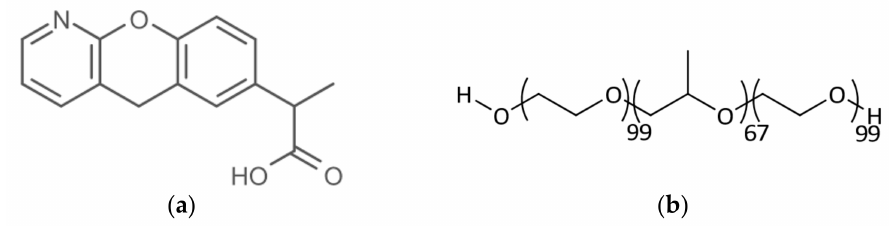
Figure 1. ( a ) Pranoprofen chemical structure [2]; ( b ) Pluronic F127 ® chemical structure